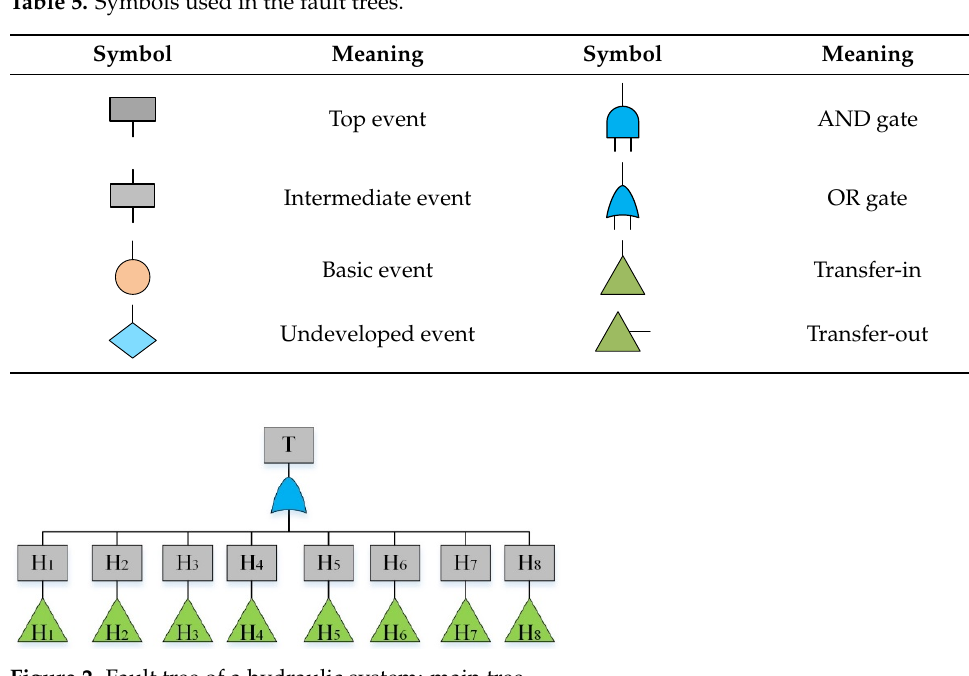
Figure 3. Fault tree of a hydraulic system: sub-tree I. Figure 4. Fault tree of a hydraulic system: sub-tree II.